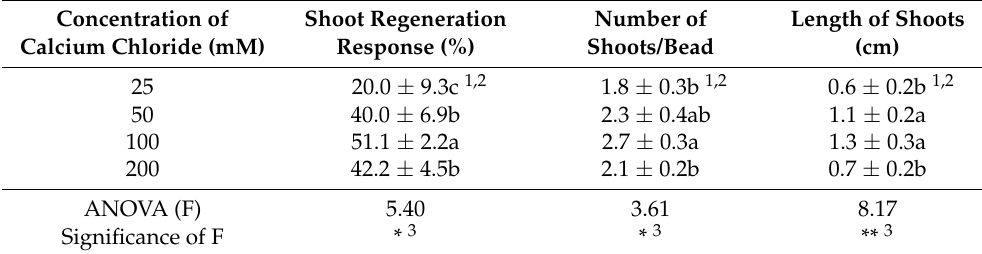
Table 3. Effect of different concentrations of calcium chloride (CaCl 2. 2H 2 O), used with 2.5% sodium alginate, on subsequent artificial seed germination of G. jasminoides, after 4 weeks of culture.